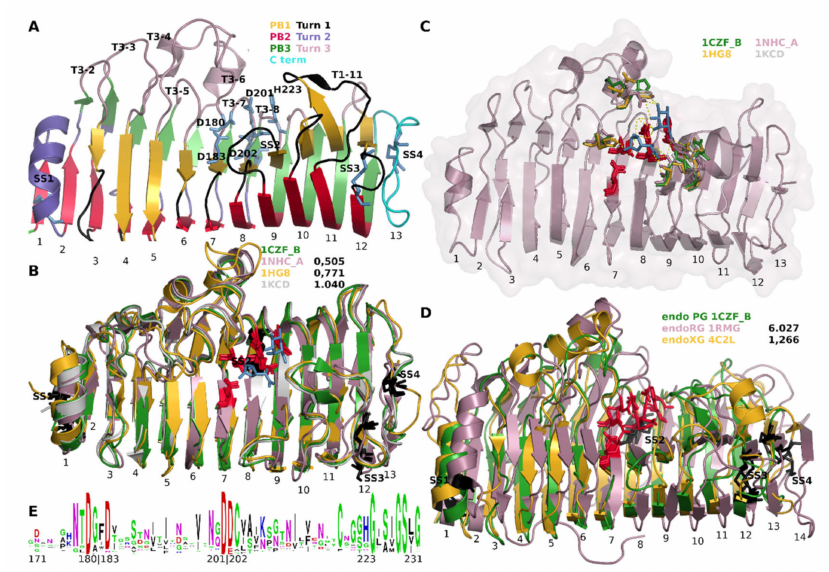
Figure 1. Global structure-function analysis of the Glycosyde Hydrolase 28 family. Numbers below the cartoons indicate the number of the separate helices or stacks. ( A ) Global architecture. Shown is chain B of 1CZF, endoPGI from A. niger . Gold: PB1 (stacks 3 to 12); red: PB2 (Stacks 2 to 12); green PB3 (Stacks 1 to 12). Black: Turn/Loop 1; Rose: Turn/Loop 2; Purple: Turn/Loop 3. The N-terminal part of the structure is supported by a single disulphide bridge (SS1), two disulphide bridges (SS3 and 4) support the C terminal part of the structure, one in Loop 1–12 and a second in the thirteenth and last stack. A fourth disulphide bridge (SS2) in Turn 3-7 supports the catalytic site that is located approximately in the centre of the slide (Turns 3-6 to 3-8). Disulphide bridges and catalytic residues are in black and blue sticks, respectively. ( B , C ) Structural alignment of endoPGs 1CZF, 1NHC, 1HG8 and 1KCD. RMSDs in Å indicate the structural dissimilarity with reference 1CZF. In blue stick are the two galacturonates co-crystallized with 1KCD. D180, D183, D200, D201 and H223 and corresponding residues in other structures are in red stick; ( C ) H bonding of galacturonates to N91, Q120, H150, D153, S201, R226, K228 and Y262 (1CZF) and corresponding residues (stick with colour according to the structure). ( D ) Structural alignment of endoPG 1CZF, endoRG 1RMG and endoXG 4C2L. Details as in ( B ); ( E ) Sequence conservation logo of GH28 superfamily region 171–231. Indicated are the highly conserved aspartates and H223, numbers according to